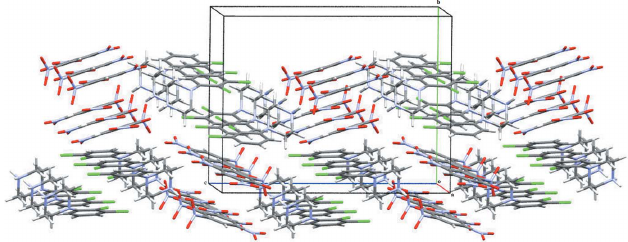
Figure 3 The three dimensional herring bone supramolecular architecture viewed along the a and c axis.